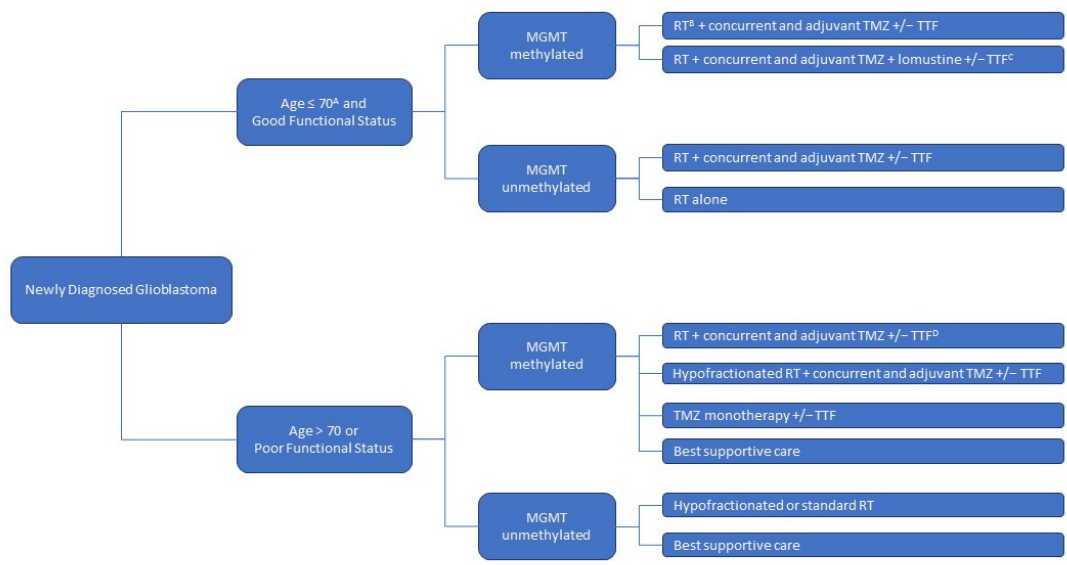
Figure 1. Approach to newly diagnosed glioblastoma treatments, following maximal safe surgical resection. MGMT = O6-methylguanine-DNA methyltransferase; RT = radiation therapy; TMZ = temozolomide; TTF = tumor-treating fields. A: Elderly status is defined as ≥ 65 in certain studies. B: A standard radiation therapy course is administered over 6 weeks. C: For MGMT-methylated patients with a good performance status, the addition of lomustine to the standard treatment with radiation therapy and temozolomide, with or without tumor-treating fields, may provide additional benefits (see text). D: In selected elderly patients with a good performance status, standard 6-week radiation therapy with concurrent and adjuvant temozolomide can be considered (see text).